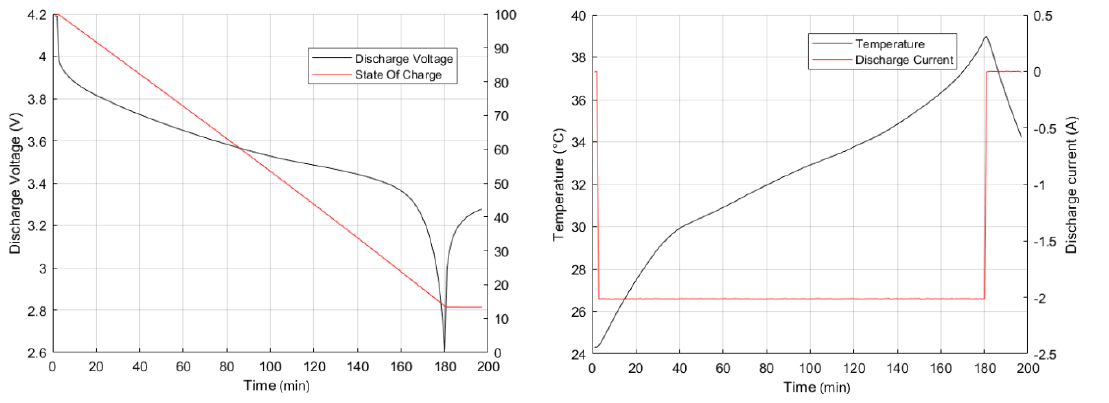
Figure 1. Discharge voltage, current, state of charge and temperature curves in a single